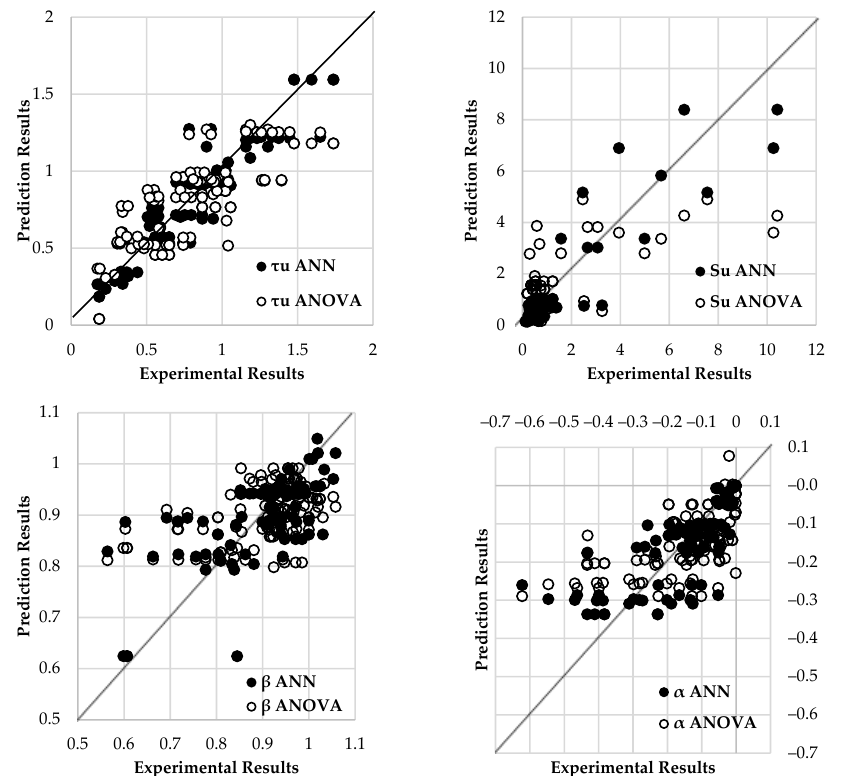
Figure 3. Predicted parameters using ANN and ANOVA vs. experimental results for squared specimens.